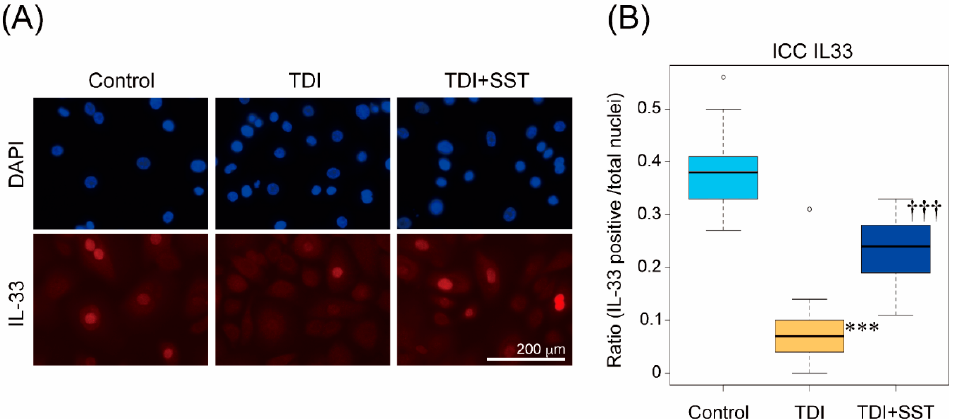
Figure 5. SST suppressed the TDI-induced IL-33 release from the nucleus of cultured nasal epithelial cells. ( A ) Representative images of cultured human nasal epithelial cells stained with anti-IL-33 antibody. Green: IL-33, Blue: DAPI. Bar = 200 µ m ( B ) Quantified data of the ratio (IL-33 positive/total nuclei). (n = 22) *** p < 0.001 Control group; ††† p < 0.001 vs. AR group. (One-way ANOVA followed by Tukey’s multiple comparisons).